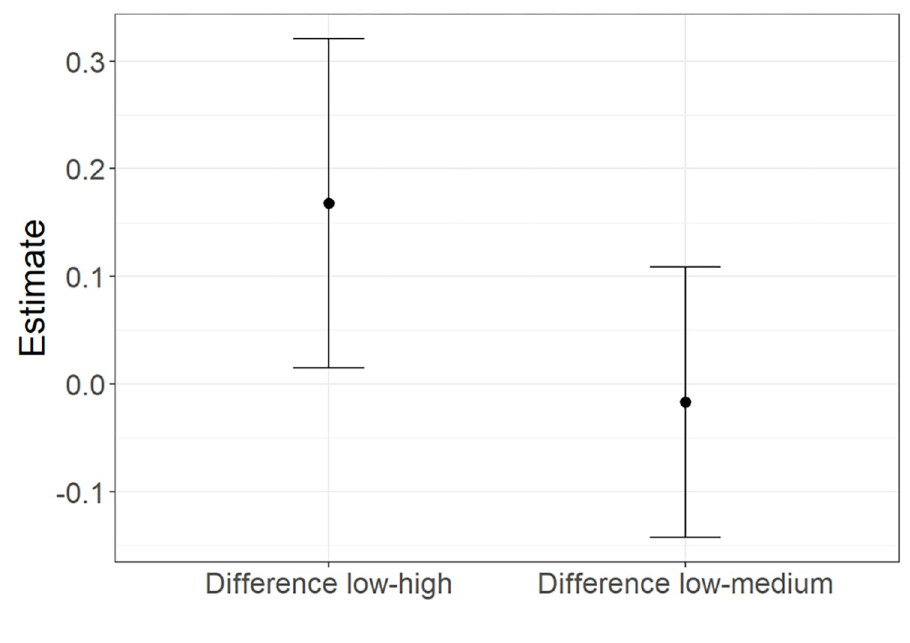
Fig 4. Button probability effect predicted by m0. Relative choice of the response with low vs high and low vs medium probability of delivering a positive vs. neutral effect, with whiskers representing 95% confidence intervals.